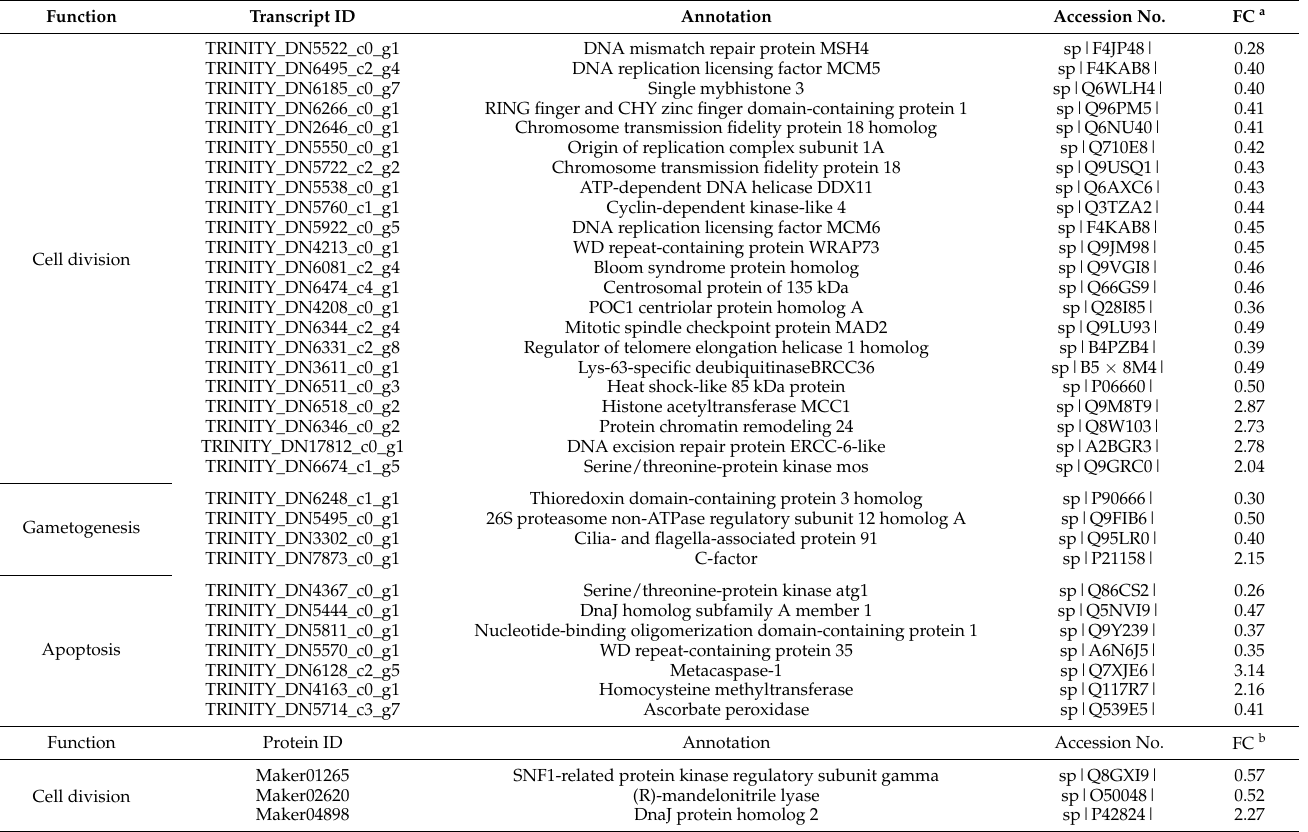
Table 5. Fluctuation of molecules in U. prolifera on cell division, gametogenesis, and apoptosis after 12 h treatment with high